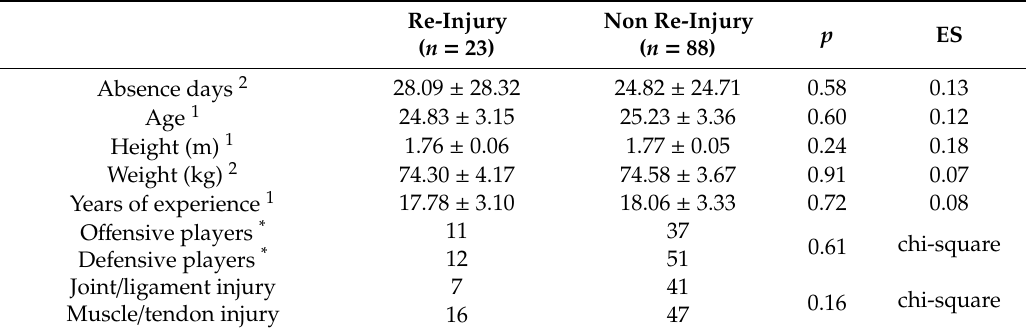
Table 1. Comparison characteristics of re-injury group and non re-injury group.